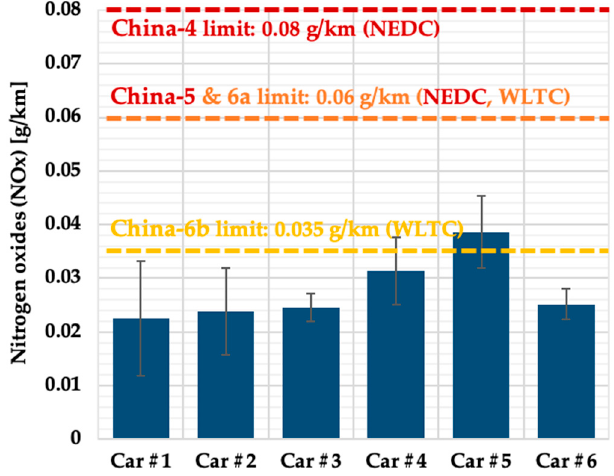
Figure 5. NOx emissions from the in-use methanol taxis.